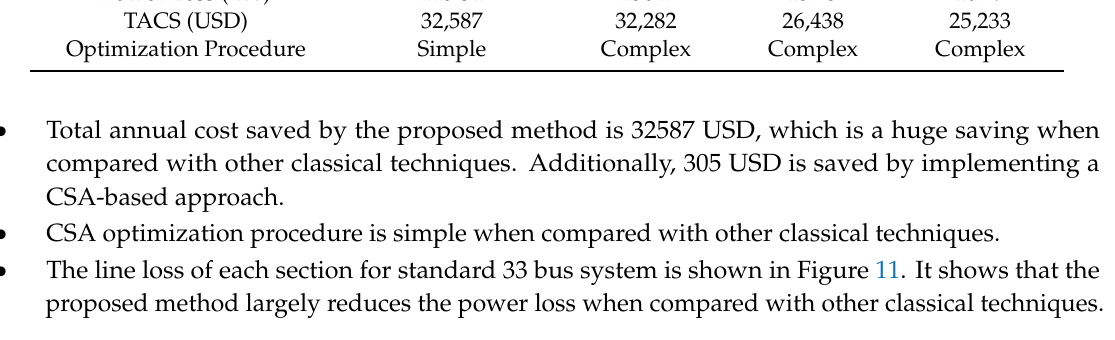
Table 7. Comparative analysis of proposed method with other classical methods for standard -69 bus Test